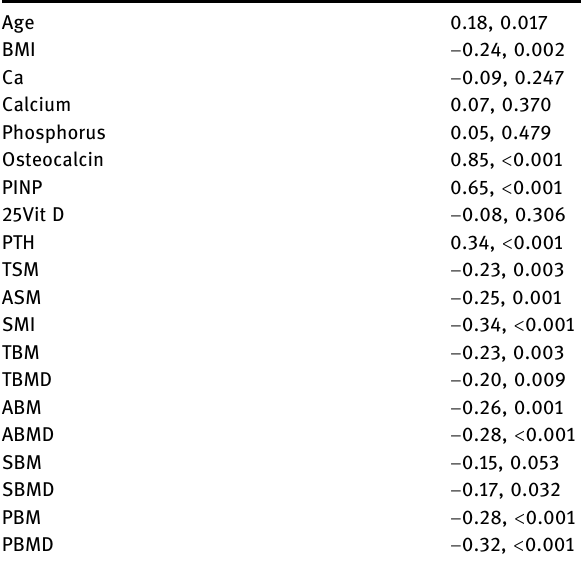
Table 2: Pearson analysis of the association of β - CTX and clinical characteristics